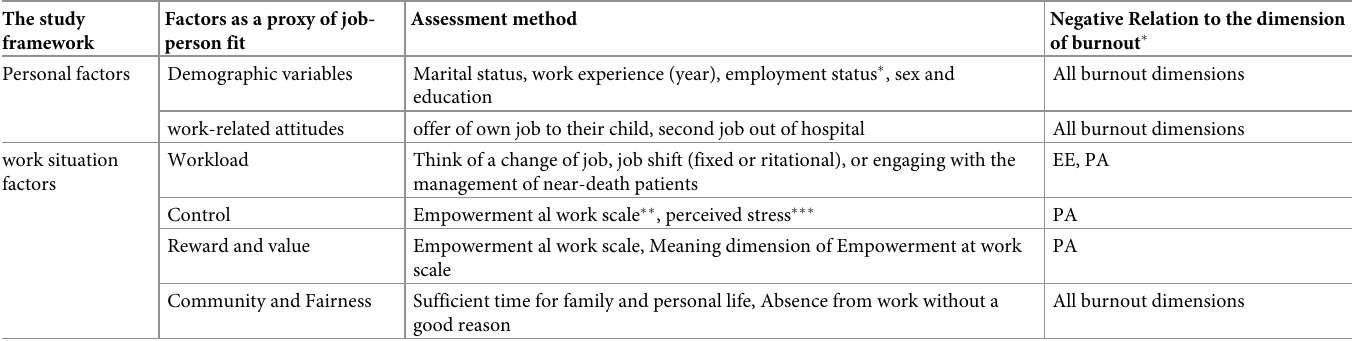
Table 1. The independent variables and their hypothesised relationships with burnout dimensions. The study Factors as a proxy of job- framework person